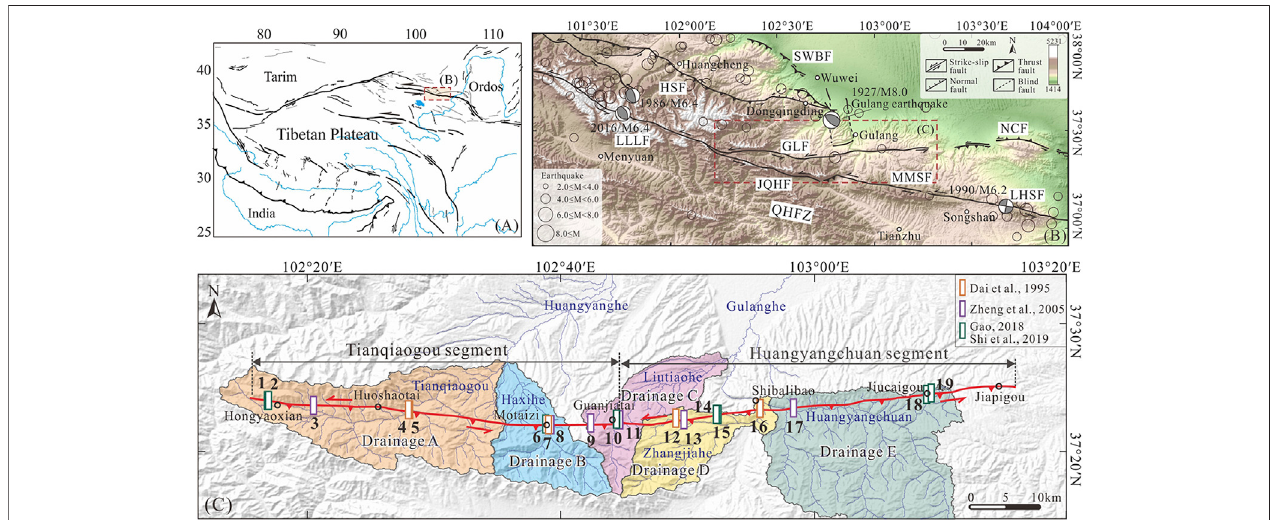
FIGURE1| Tectonicsetting anddistributionmapoftheGulangfault. (A) Tectonic locationofthestudyarea. (B) .Mainactivefaultsaroundthestudyarea.Thefault locations are modi fi ed from (Zheng et al., 2016) and (Guo et al., 2019). The seismic data (hollow dots) are from USGS. Focal mechanism solutions (gray beach balls) are from(Houetal.,1999)and(Heetal.,2020).Abbreviations:QHFZ (cid:1) Qilian – Haiyuanfaultzone;LLLF (cid:1) Lenglonglingfault;JQHF (cid:1) Jinqianghefault;MMSF (cid:1) Maomaoshan fault; LHSF (cid:1) Laohushan fault; HSF (cid:1) Huangcheng-Shuangta fault; SWBF (cid:1) South Wuwei Basin fault; GLF (cid:1) Gulang fault; NCF (cid:1) North Changlingshan fault. (C) Distributionmap oftheGulang fault and fi ve maindrainages (Drainages AtoE) alongthefault.The fault locationsare from(Shiet al.,2019).Rectangularboxes represent the trench locations.